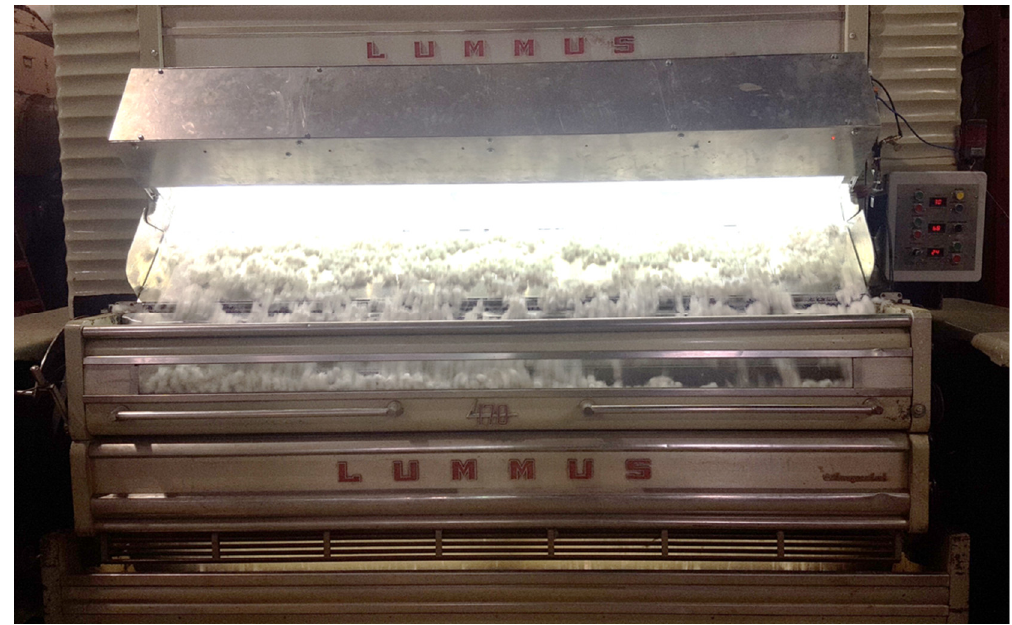
Figure 6. Plastic detection–ejection system installed and running at a commercial cotton gin.